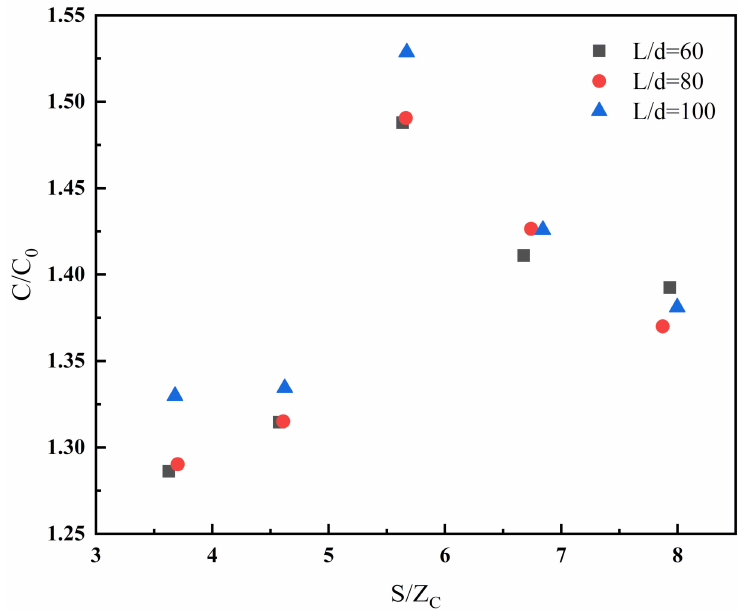
Figure 12. The relationship between the dimensionless flame length C / C 0 and S / Z C